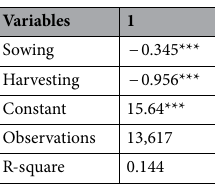
Table 3. Sowing and harvesting impact on rice yield in the Punjab. ***p < 0.01, **p < 0.05, *p < 0.1, Robust standard errors.